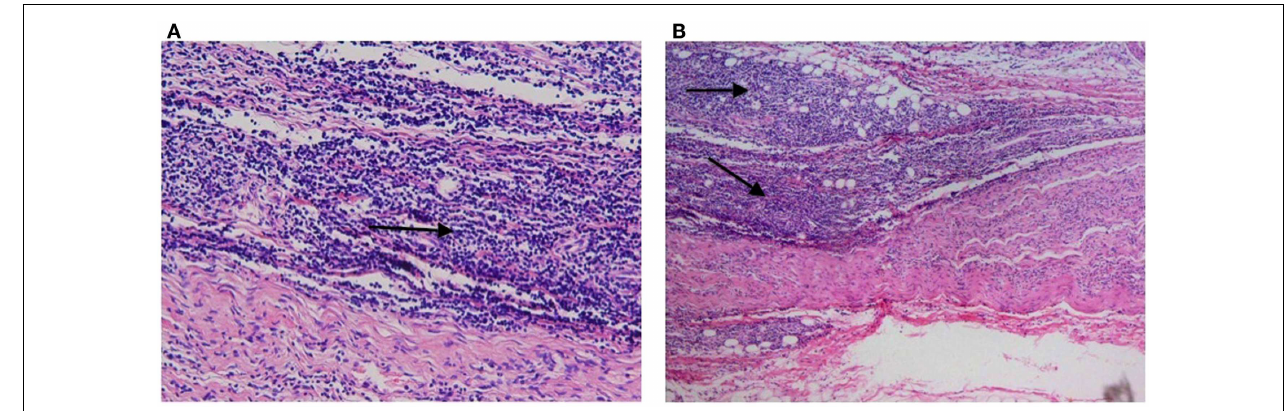
FIGURE 1 | Hematoxylinand eosin (H&E) stains . Post-mortem examination revealed diffuse and monotonous propagation of lymphoma cells (arrows) infiltrating peripheral nerves without involvement of the brain parenchyma or